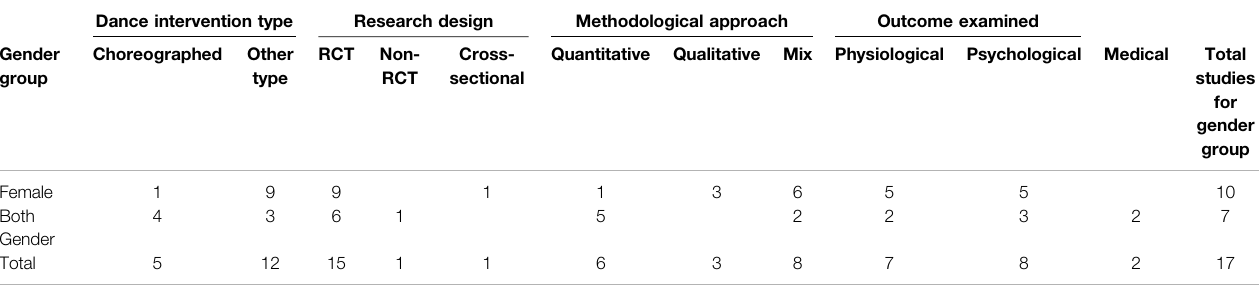
TABLE 1 | Summary of participant age groups, research design, methodological approach and outcome